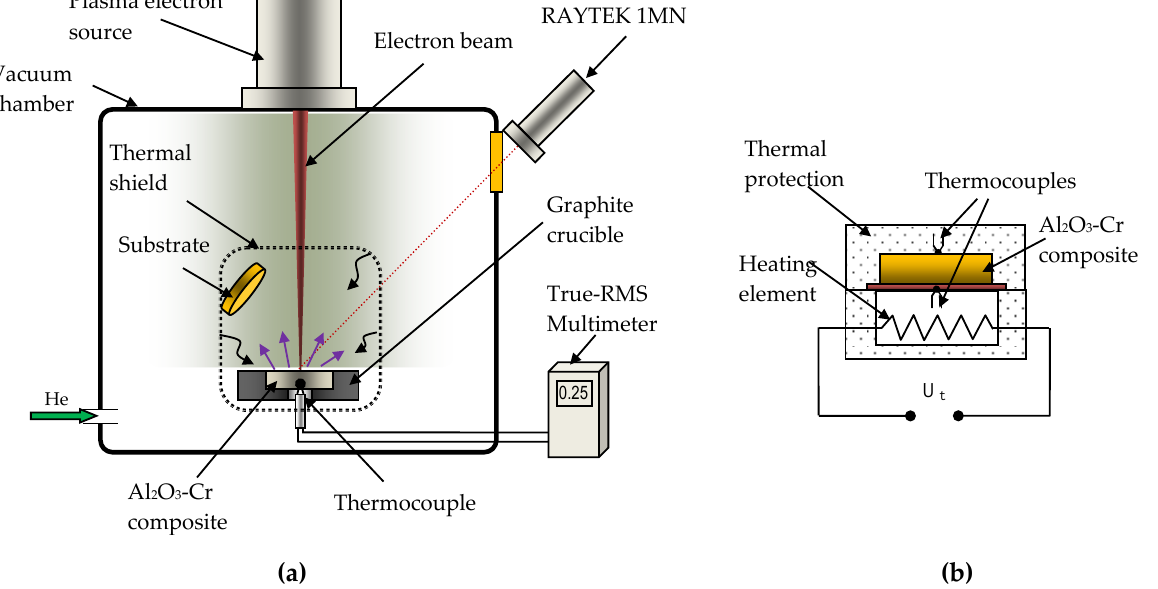
Figure 1. Schematic diagram of the experimental setup ( a ) and electrical heater ( b ). The composite surface during sintering was monitored remotely by a RAYTEK 1MH (Raytek Corp., Santa Cruz, CA, USA) infrared pyrometer with measurement range 550–3000 ◦ C. A tungsten–rhenium thermocouple was used to measure the temperature of the composite non-irradiated side. The thermocouple and the composite surface were in tight contact with each other. The thermocouple and the pyrometer were calibrated by heating of a thin copper plate. The difference in readings did not exceed 10 ◦ C. Current through the composite during its irradiation was measured by replacing the thermocouple with a flat metal electrode (not shown in Figure 1). The sample was placed on this electrode on the irradiated side. The current through the sample was measured by a True-RMS Multimeter 289 (Fluke Corp., Everett, WA, USA), with one sensing wire connected to the electrode and the other